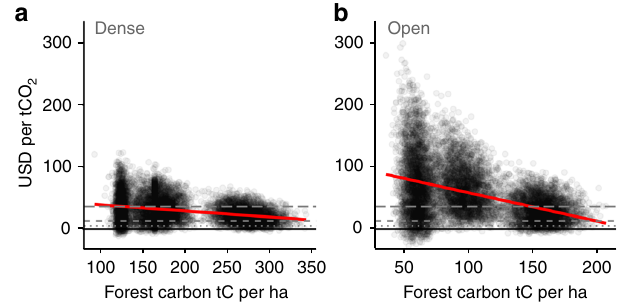
Fig. 4 Effect of forest carbon stock on breakeven carbon prices in dense and open forests. The response of breakeven carbon price to forest carbon stock under the “ No timber logged ” scenario is shown for a dense and b open forests. Each dot represents the outcome of one model iteration. Grey dashed lines indicate real-world carbon prices, following Fig. 3. Red lines represent a linear model relating forest carbon to breakeven carbon price (with grey shaded SE too narrow to be visible)